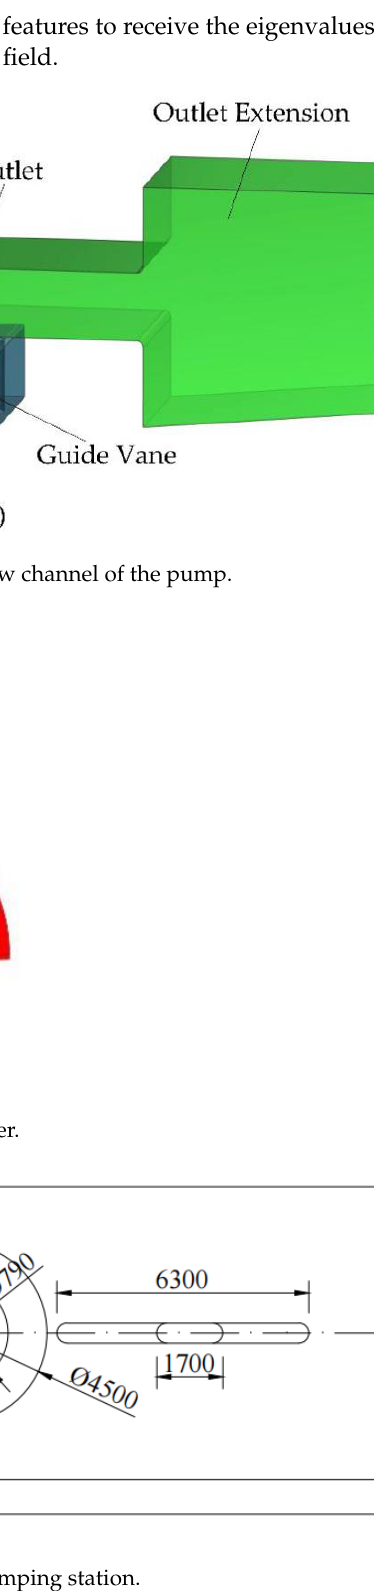
Figure 3. Top view of the full flow path of the pumping station.